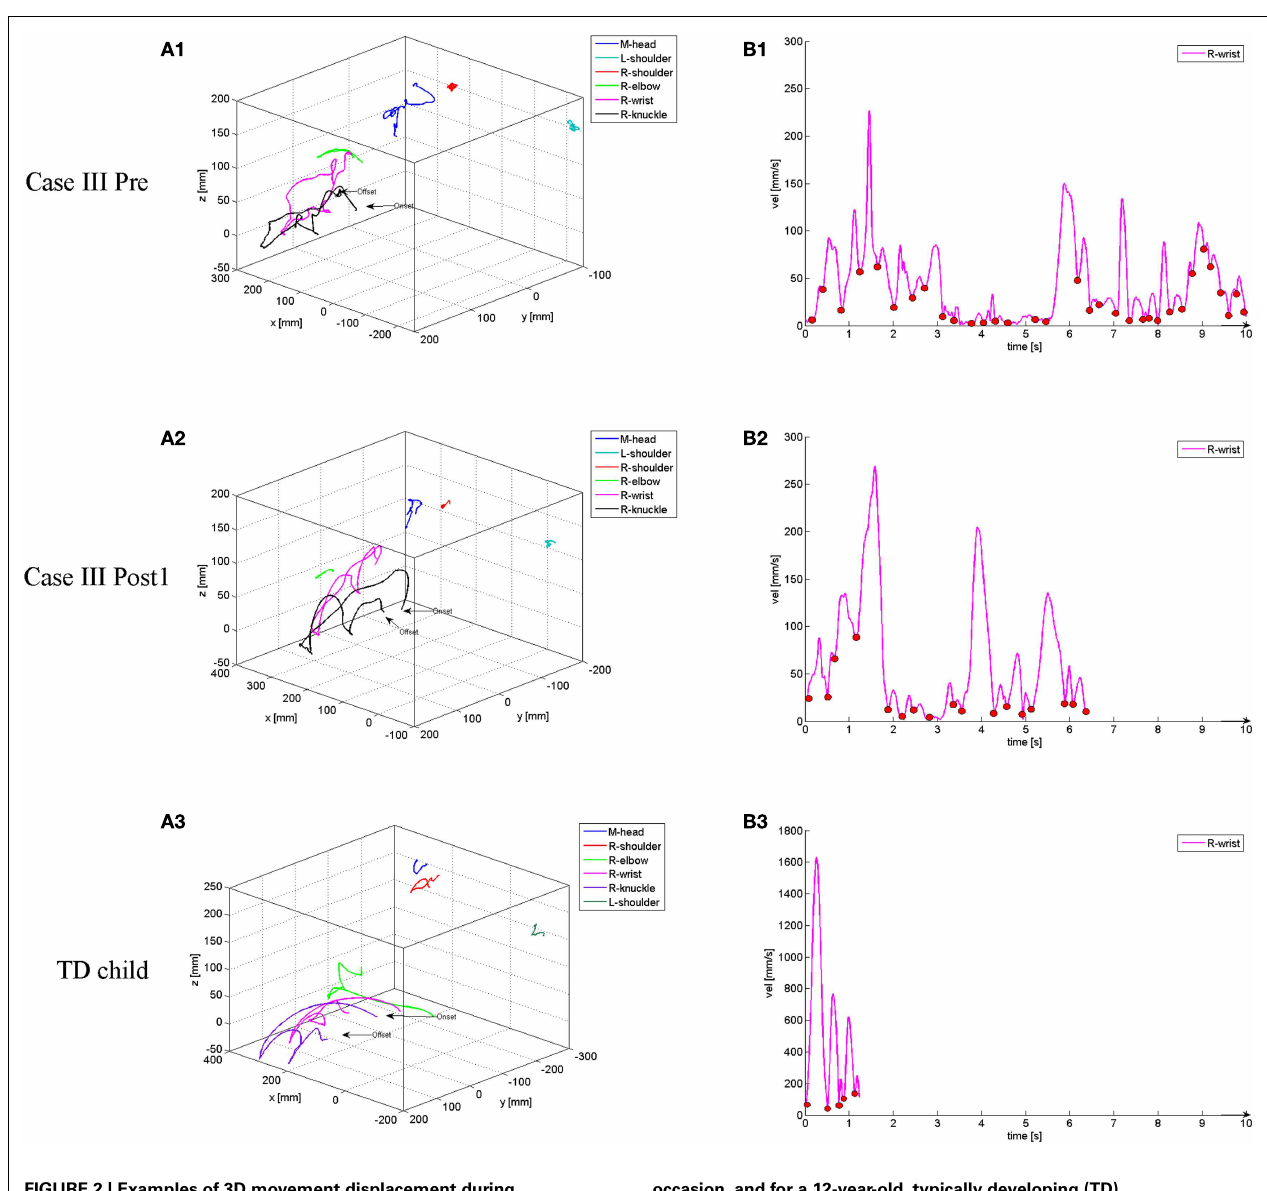
FIGURE 2 | Examples of 3D movement displacement during unimanual light-switch task performance (starting from resting and sequentially moving to the top button, the middle button, and the bottom button) with corresponding velocity profiles from the wrist marker for Case III at the Pre (A1,B1) and Post1 (A2,B2)